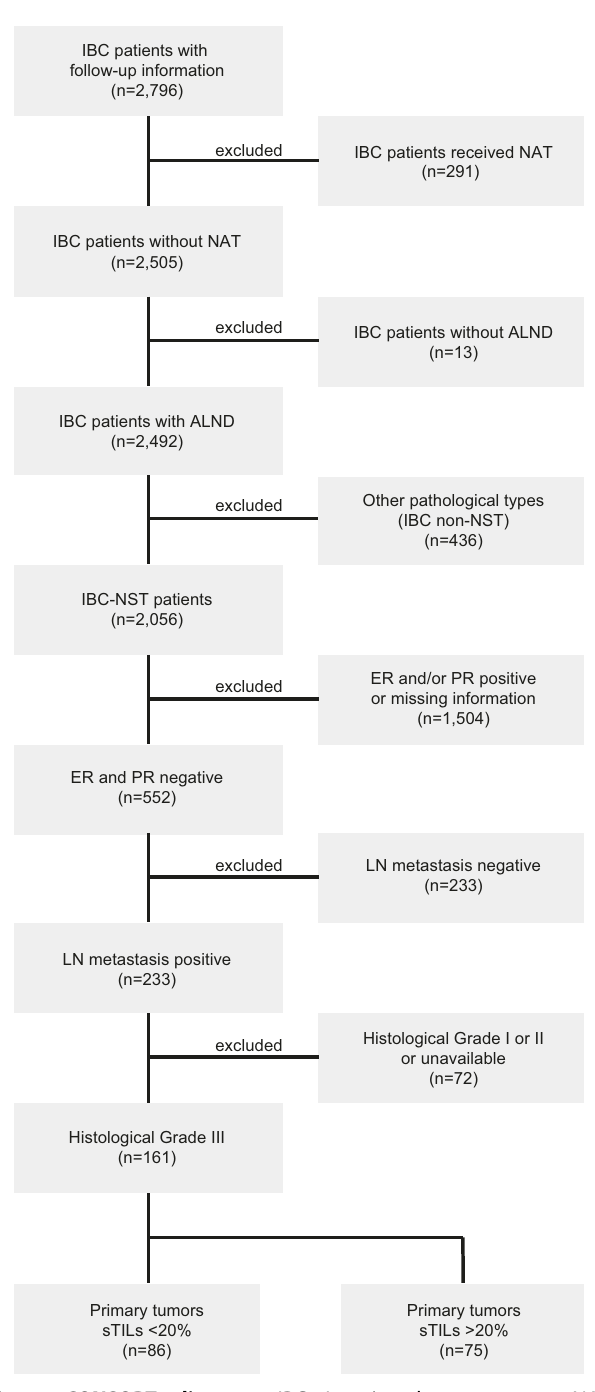
Fig. 1 CONSORT diagram. IBC Invasive breast cancer, NAT neoadjuvant therapy, IBC-NST invasive breast cancer of no special type, ER estrogen receptor, PR progesterone receptor, sTILs stromal tumor-in fi ltrating